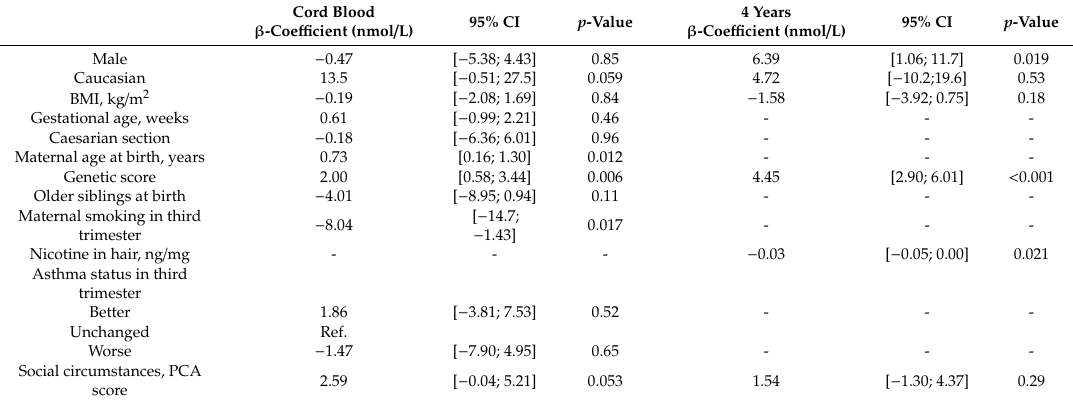
Table 3. Univariate analyses of determinants for cord blood and age 4 years season-adjusted 25(OH)D